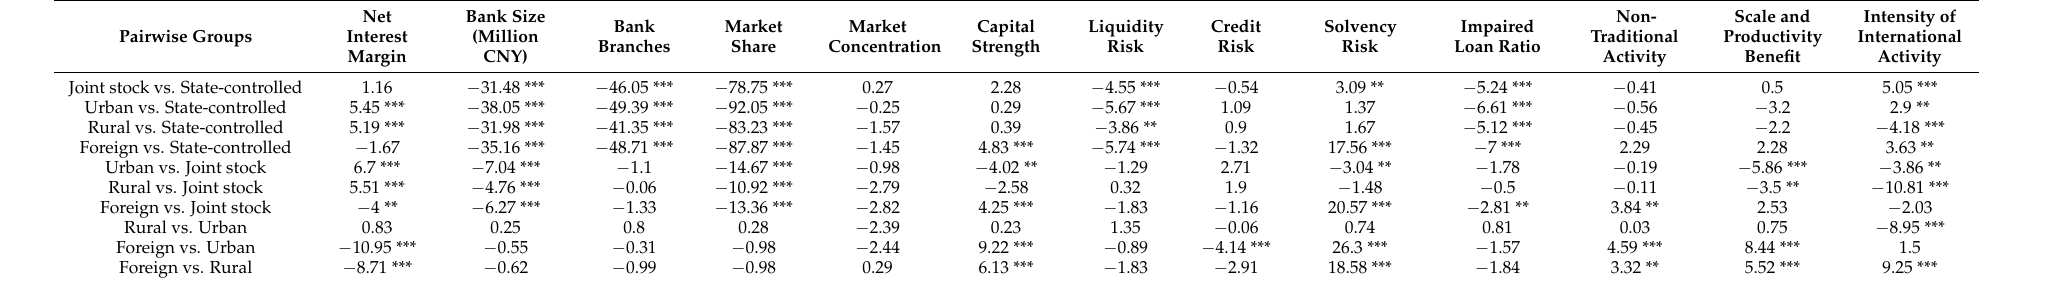
Table 3. Bank groups’ pairwise comparison—Tukey post hoc test results.